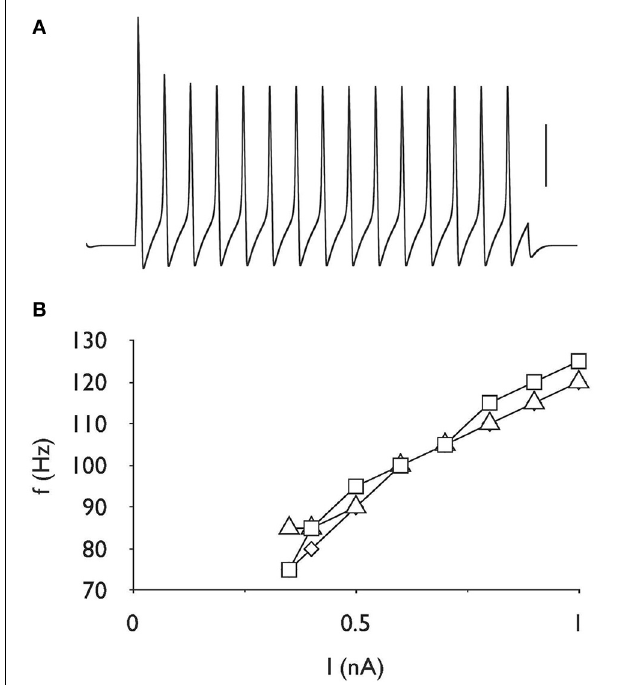
FIGURE 4 | Firing rate is unchanged after AOE. (A) Action potentials evoked by a current of 0.35nA for 200ms, demonstrating the capacity for repetitive firing in the control model. Scale bar is 50mV and the duration of the entire trace is 250ms. (B) Stimulus intensity versus frequency response showing linear increase in firing frequency in response to increasing stimulus current up to 1nA. There is little difference in the firing frequency properties for control ( (cid:2) ), AOE 1 ( ♦ ) or AOE 2 ( (cid:4) ) treatment. Note y-axis starts at 70Hz.